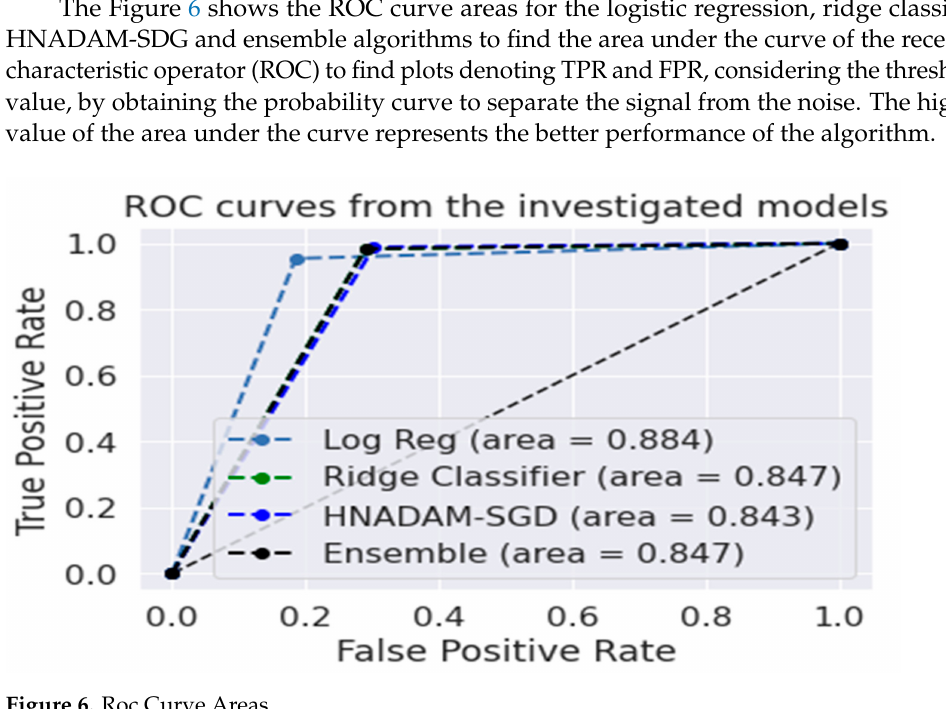
Figure 6. Roc Curve